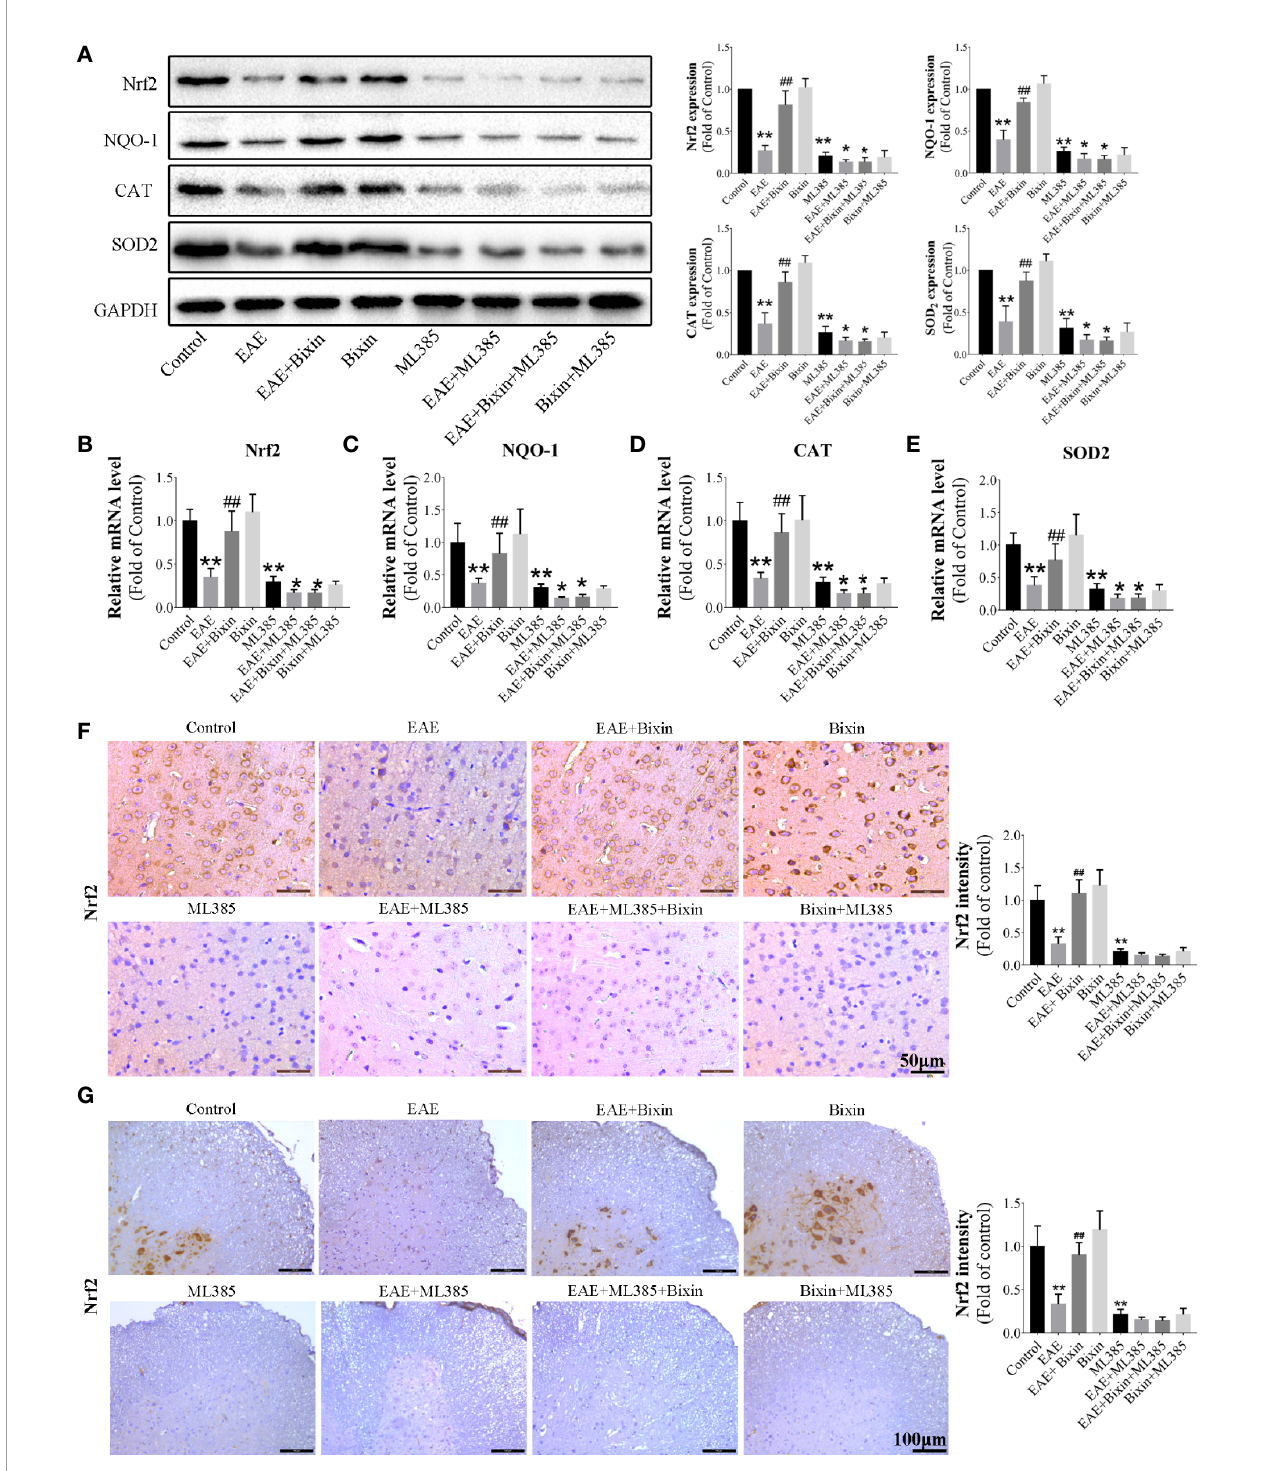
FIGURE 6 | Bixin activates the NRF2 signaling in EAE mice (A) . The protein levels of NRF2 and downstream genes Catalase, NQO-1, and SOD2 in the brain tissues were assessed by western blotting, and the quantitative results are shown (B – E) . mRNA expression of NRF2, Catalase, NQO-1, and SOD2 in the CNS tissues were quantitated by qRT-PCR. IHC of NRF2 in brain sections (F) (Scale bars: 50 m m) and spinal cord sections (G) (Scale bars: 100 m m). Data shown in graphs represents the means ± SD (n = 5). *P < 0.05, **P < 0.01, vs. control group or ML385 group; ## P < 0.01, vs. EAE group or EAE + ML385